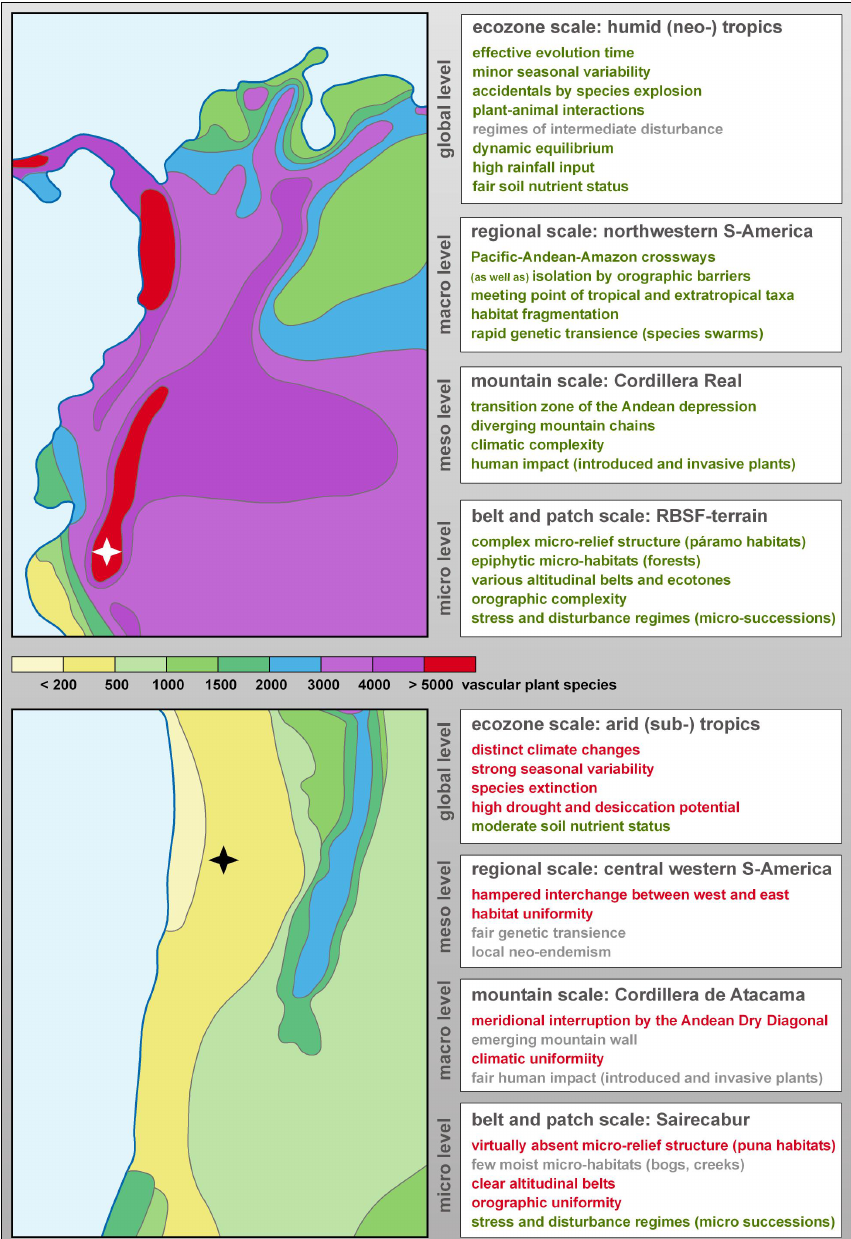
Fig. 2. Scale dependent factors contributing to plant diversity within the study area in southern Ecuador (above) and in the Cordillera de Atacama (below). Factors of predominantly positive effect on species richness are printed in green, while negative and minor consequences are in red and grey, respectively. Important controls of biodiversity within the four levels from global to microscale are expressed by boxes. The plant diversity maps on the left are based on a recent world map by Barthlott et al.